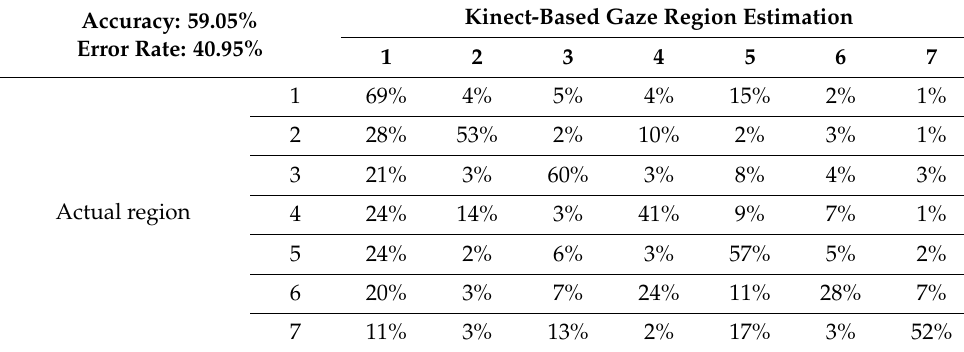
Table 4. Confusion matrix using method 3 (only two features: yaw and pitch) and Kinect. Accuracy: 59.05%